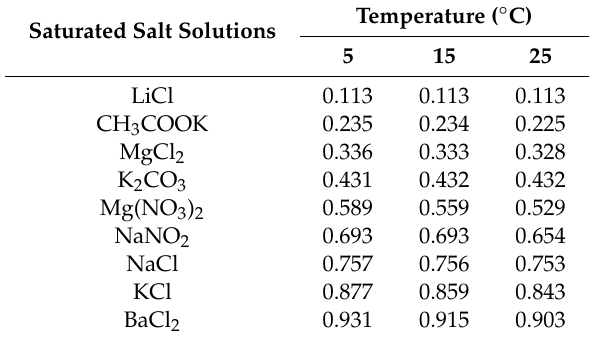
Table 1. Water activity of selected saturated salt solution at 5, 15 and 25 ◦ C. Saturated Salt